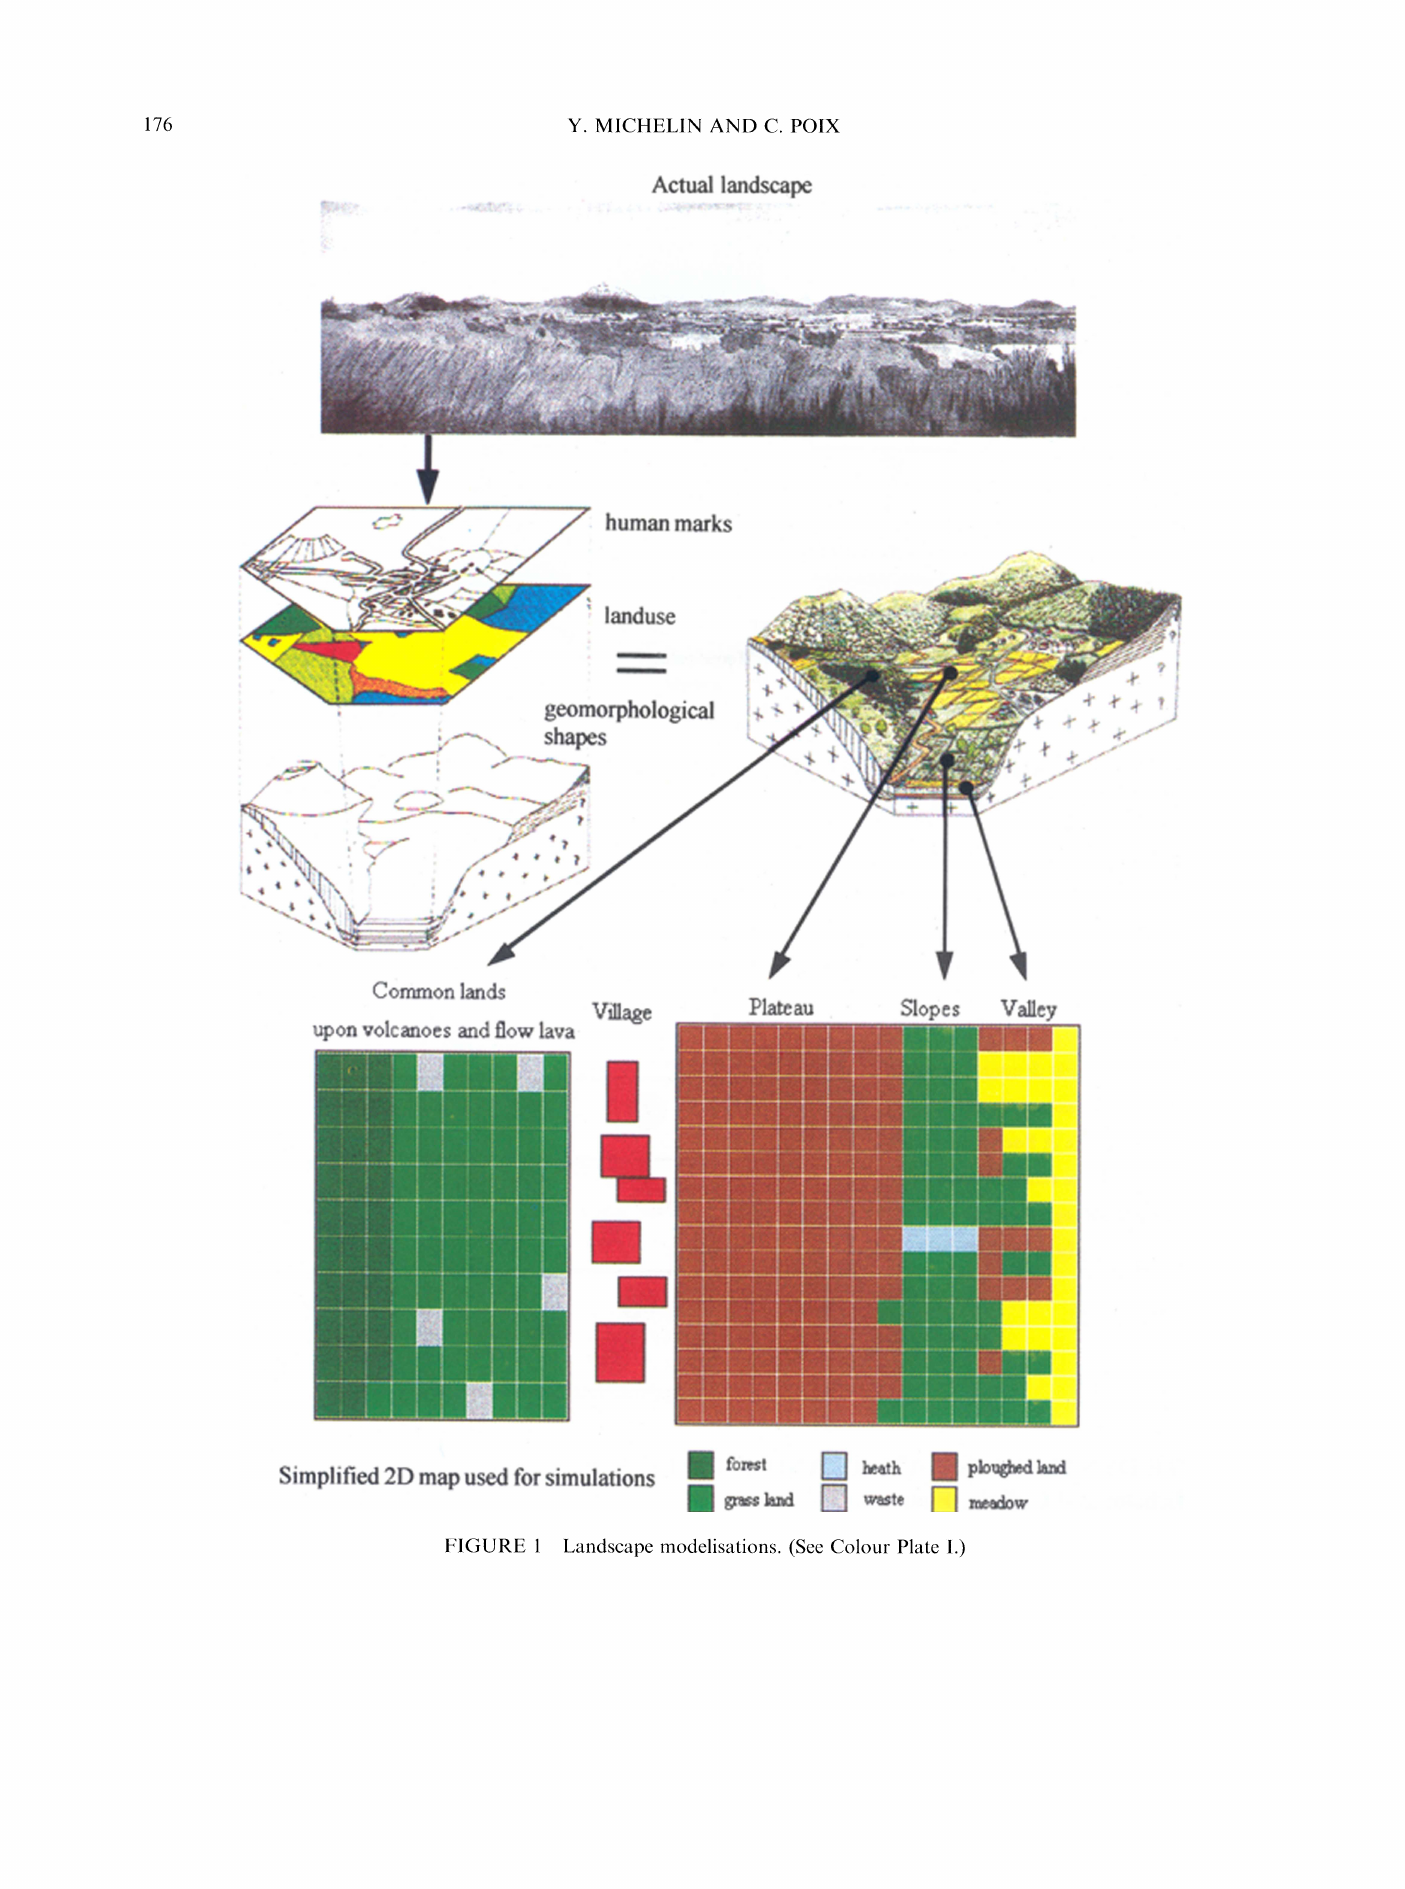
FIGURE Landscape modelisations. (See Colour Plate